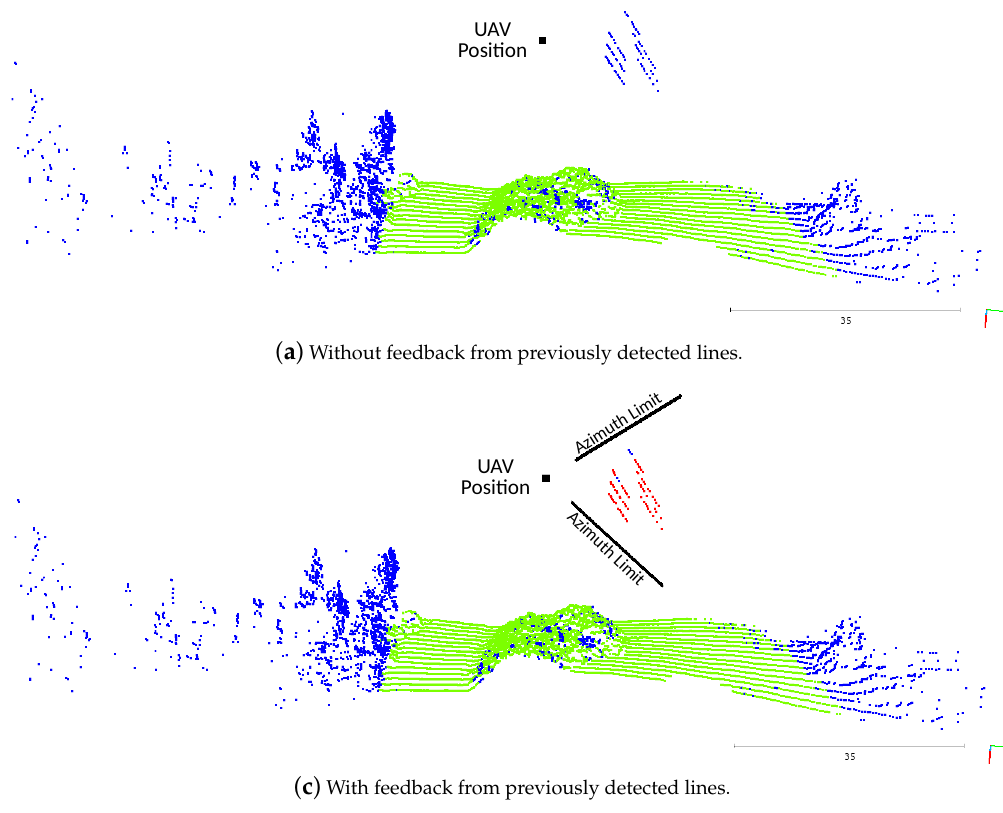
Figure 15. Effect of the feedback about previously detected